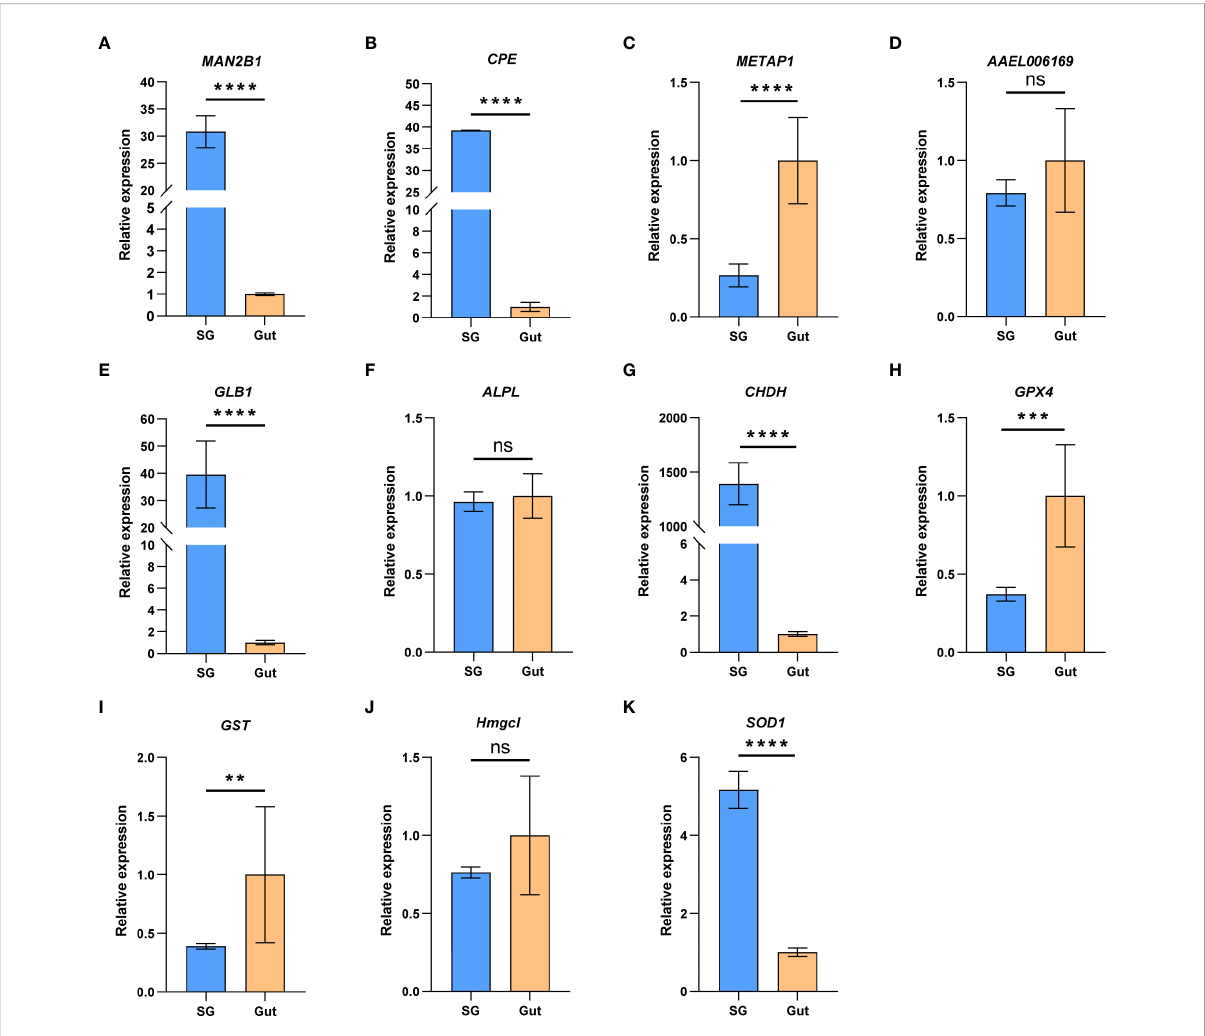
FIGURE 2 The relative gene expression of the 11 feeding-related genes between salivary glands (SG) and gut (Gut) of Pseudoregma bambucicola detected by RT-qPCR. (A) lysosomal a -mannosidase ( MAN2B1 ); (B) carboxypeptidase E like ( CPE ); (C) methionine aminopeptidase-related gene ( METAP1D ); (D) lysosomal aspartic protease (AAEL006169); (E) b -galactosidase ( GLB1 ); (F) alkaline phosphatase ( ALPL ); (G) glucose dehydrogenase ( CHDH ); (H) phospholipid hydroperoxide glutathione peroxidase ( GPX4 ); (I) glutathione S-transferase ( GST ); (J) hydroxymethylglutaryl-CoA lyase ( Hmgcl ); (K) superoxide dismutase ( SOD1 ). Heat shock protein 70 A1 and microsomal glutathione S-transferase 1 were used as internal reference genes. Asterisks above the bars indicate signi fi cant differences (** P < 0.01; *** P < 0.001; **** P < 0.0001). “ ns ” indicates not signi fi cant (P >